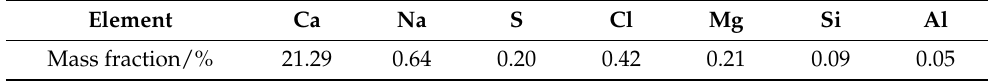
Table 2. Chemical composition of oyster shell.